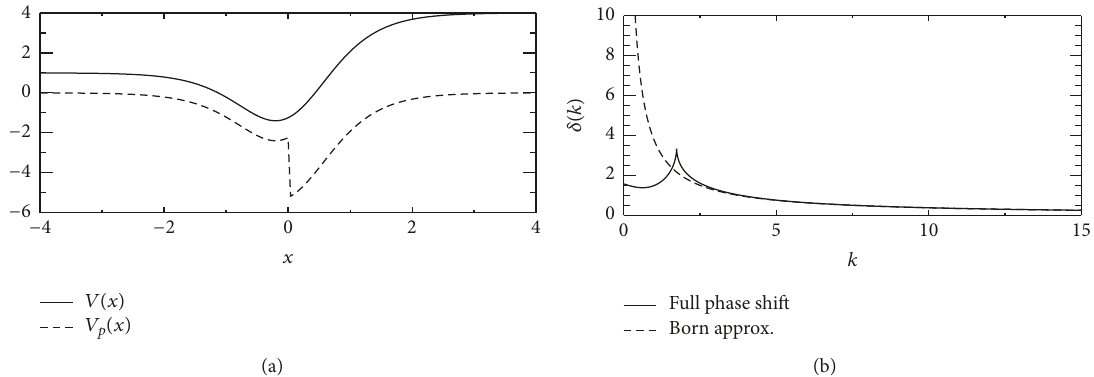
Figure 4: (a) Potential ( 𝑉 ) and pseudopotential ( 𝑉 푝 ) for fluctuations about a 𝜙 6 soliton with 𝑎 = 0 . The pseudopotential is shown for 𝑥 푚 = 0 . (b) Resulting phase shift, that is, (1/2𝑖) lndet 𝑆 (full line), and its Born approximation (dashed line).